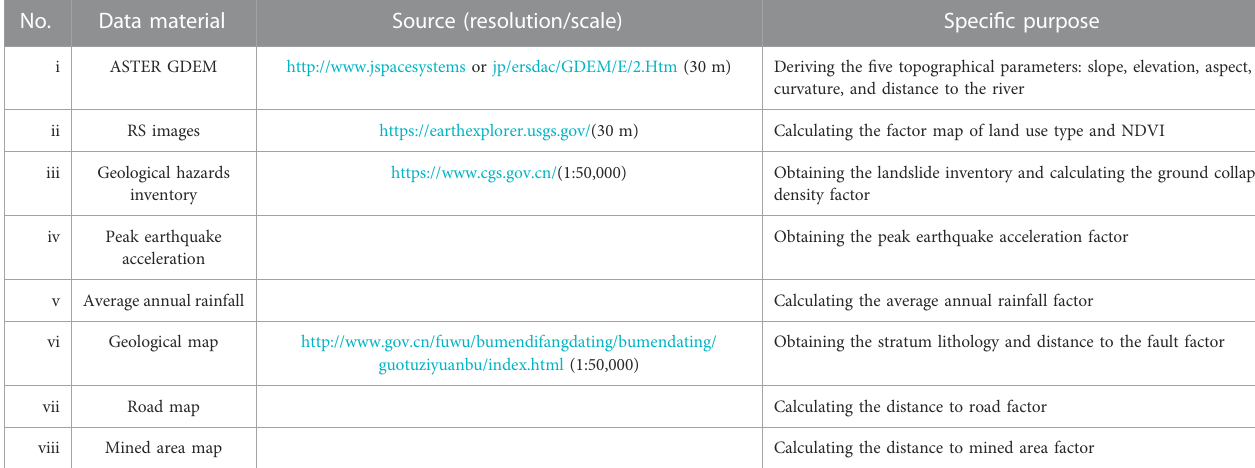
TABLE 1 Source and characteristic of Fenxi coal mine data materials.